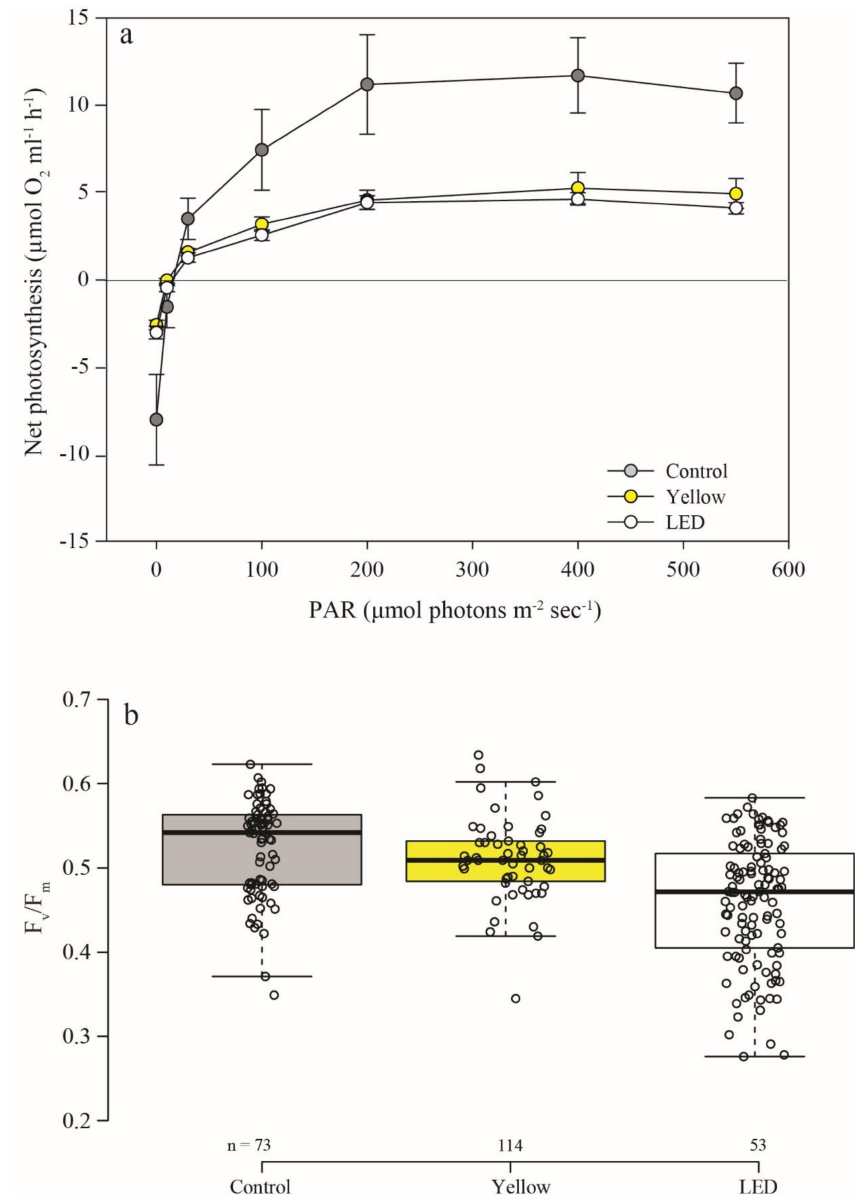
Figure 4. Photosynthesisefficiencyoftheexperimentalcoralsafteroneyear. ( a )PE(photosynthesis-energy) curve of the different light treatments—control (ambient, gray), ‘Yellow’ (fluorescent lamp, yellow), and ‘LED’ (LED lamp, white). Net-photosynthesis mean ± SE, under increasing light irradiance PAR (0, 10, 30, 100, 200, 400, 550 µ mol photons m − 2 s − 1 ); n = 4 metabolic chamber measurements of individual tiles. ( b ) Photosynthetic maximal quantum yield (F v / F m ) of the control (gray), ‘Yellow’ (yellow), and ‘LED’ (white). ( n = the number of areas of interest measurement